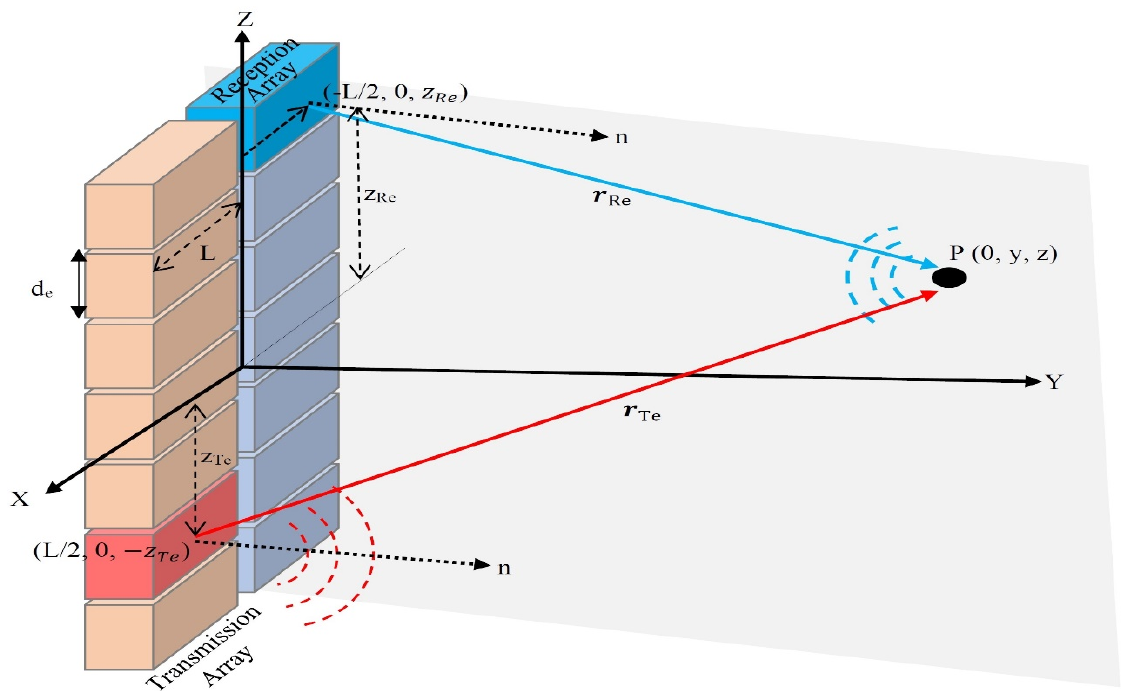
Figure 2. Illustration of the total focusing method (TFM) image reconstruction procedure when the full matrix capture (FMC) data are acquired using a pulse-compression-based linear phased-array (PuC-PA) system. Two separated array transducers are used for the transmission and reception of ultrasonic testing (UT) signals, and the plane in the middle of the two transducers is visualized.